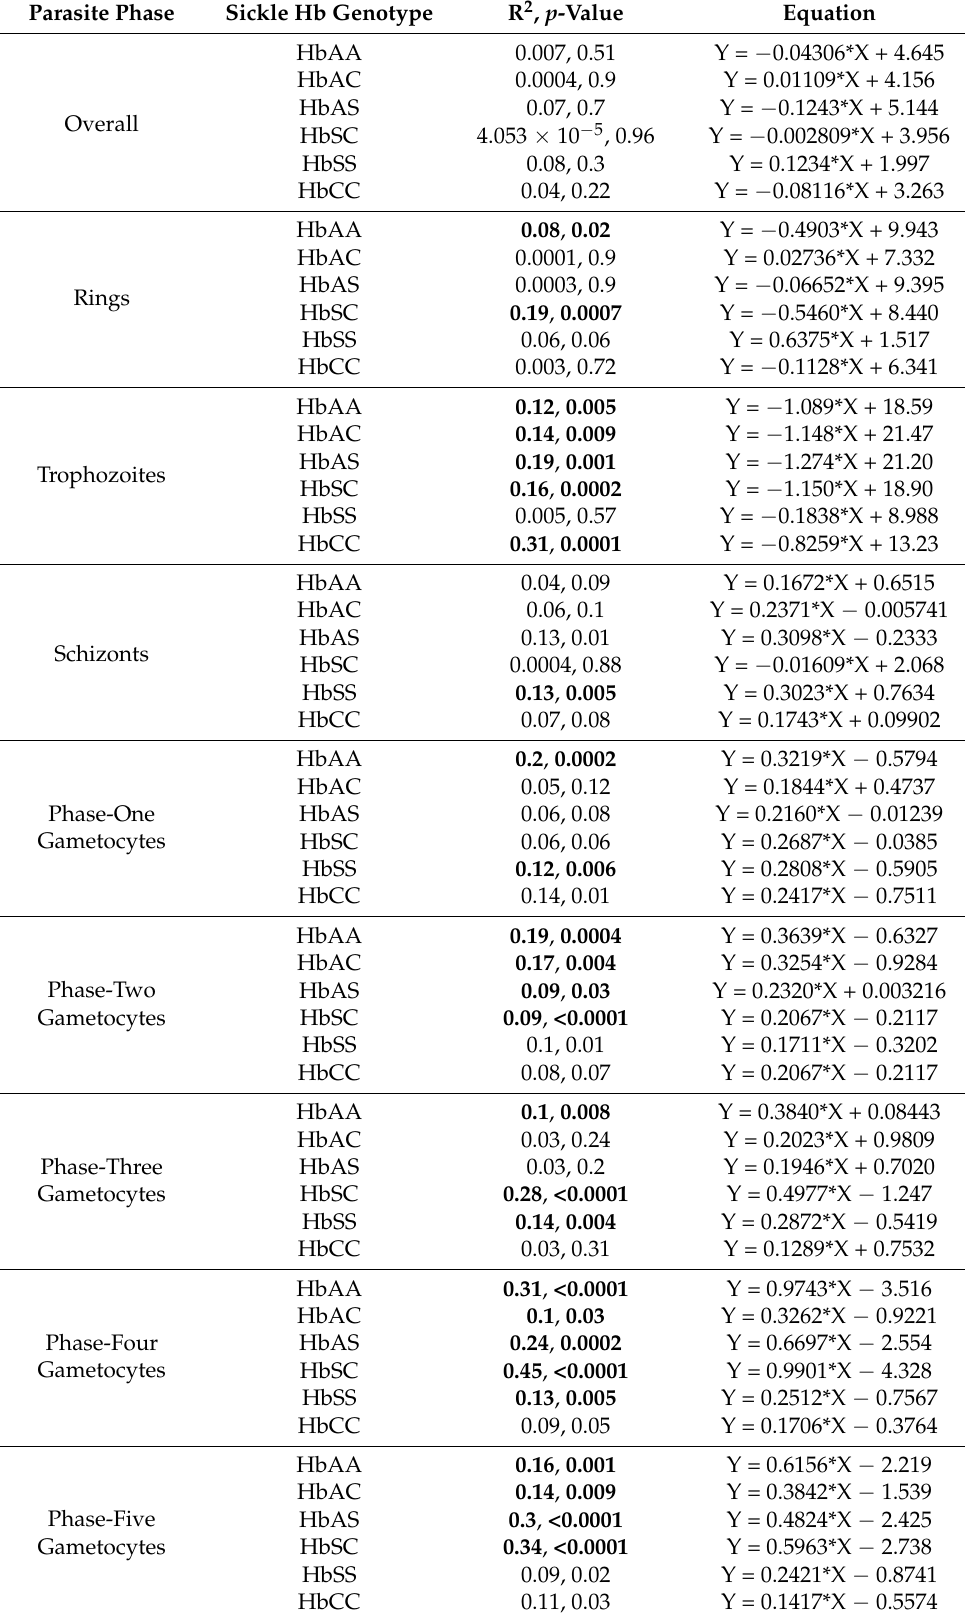
Table 1. Linear regressions for each genotype for overall parasite count and for each phase over 16